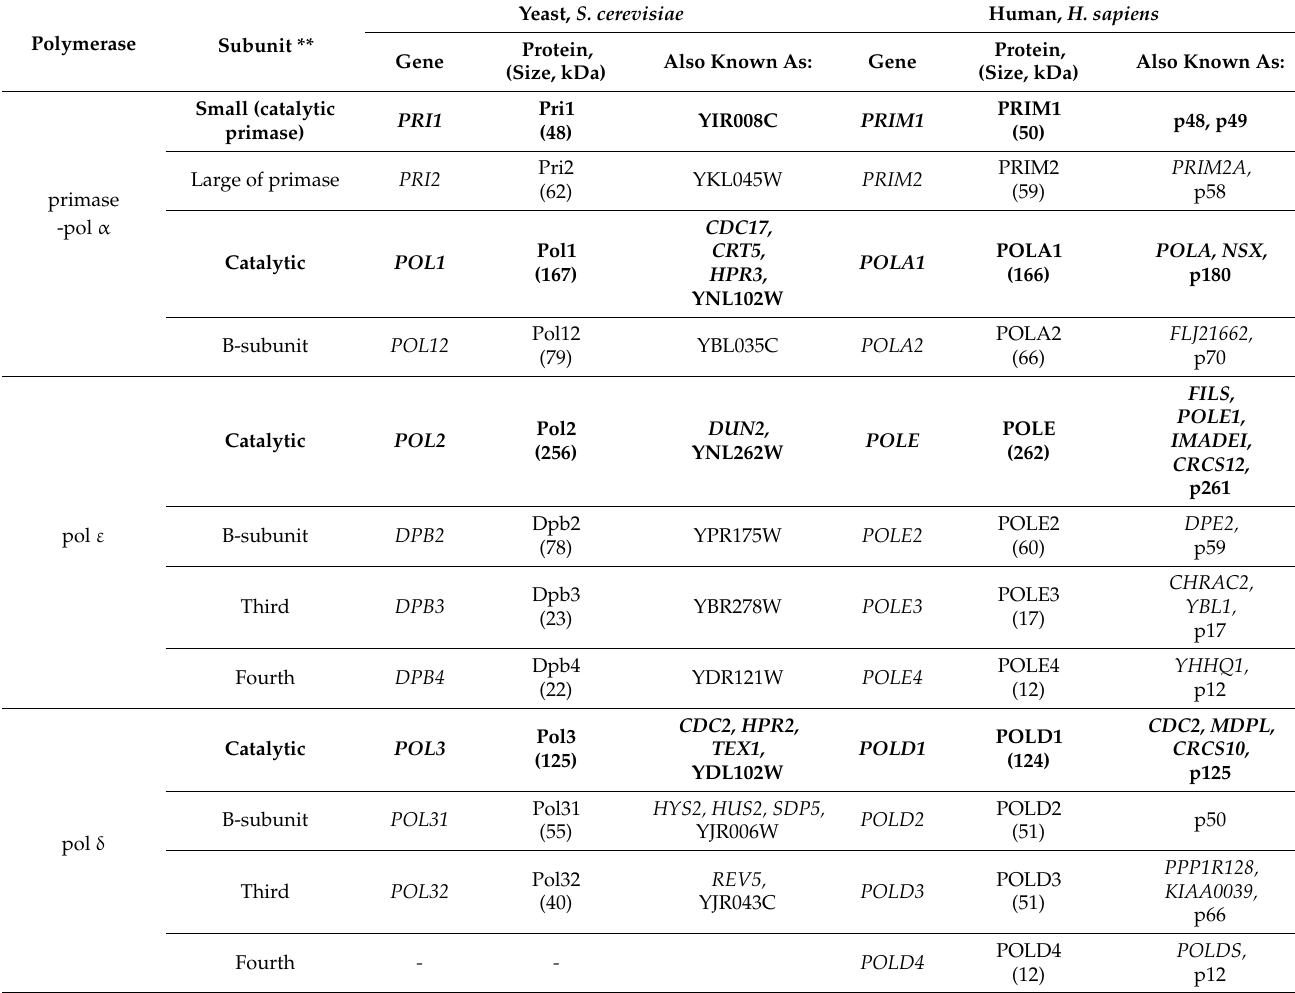
Table 1. Nomenclature of subunits of yeast and human B-family DNA polymerases